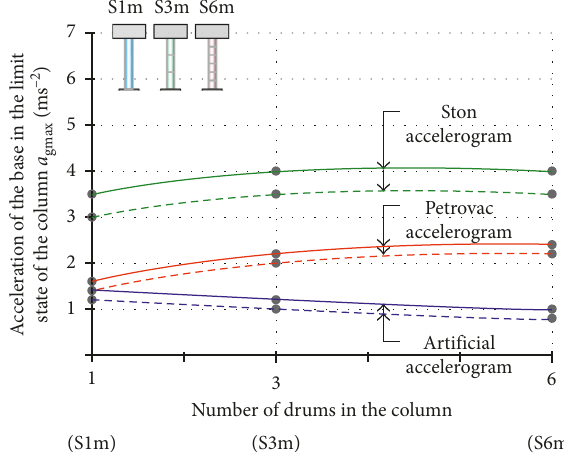
Figure 6: Maximum base acceleration a columns S1m, S3m, and